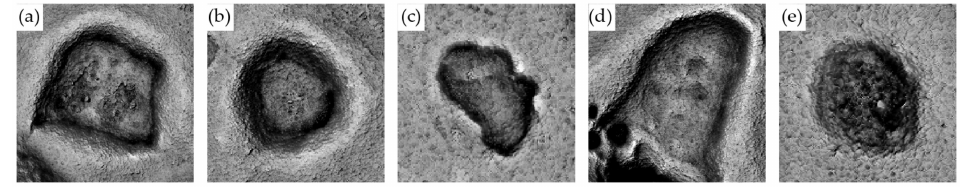
Figure 7. The same aguadas and water reservoirs as in Figure 6, as evident in a 0.5 m resolution flat terrain VAT. The scale varies. Some have a very pronounced embankments, seen as bright hallos ( a , b , d ), while others less so ( c , d ).